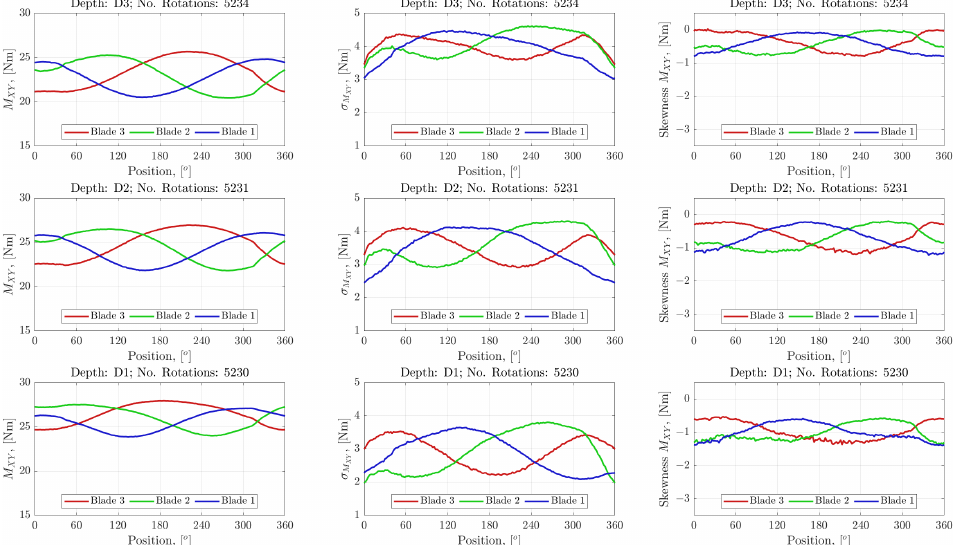
Figure 17. Plots showing the positional variation statistically of the out-of-plane BRBM measurements taken at different submersion depths. Leftmost charts show mean BRBM, central charts show standard deviation and rightmost charts show skewness. Upper, middle and lower charts show submersion depths D3, D2 and D1, respectively. The data shown are for the JSP